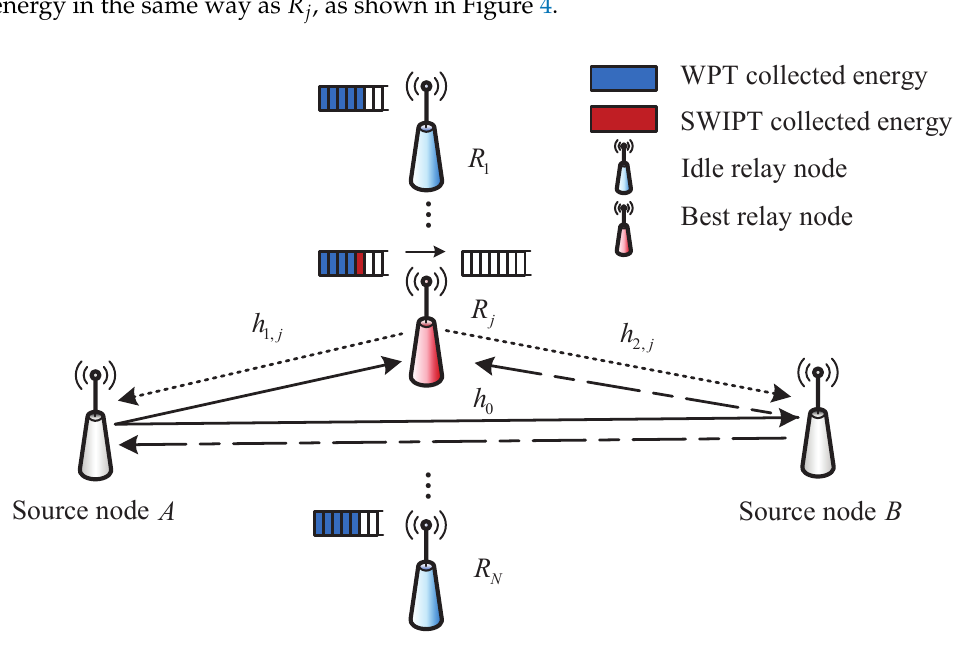
Figure 4. Relay energy storage model for